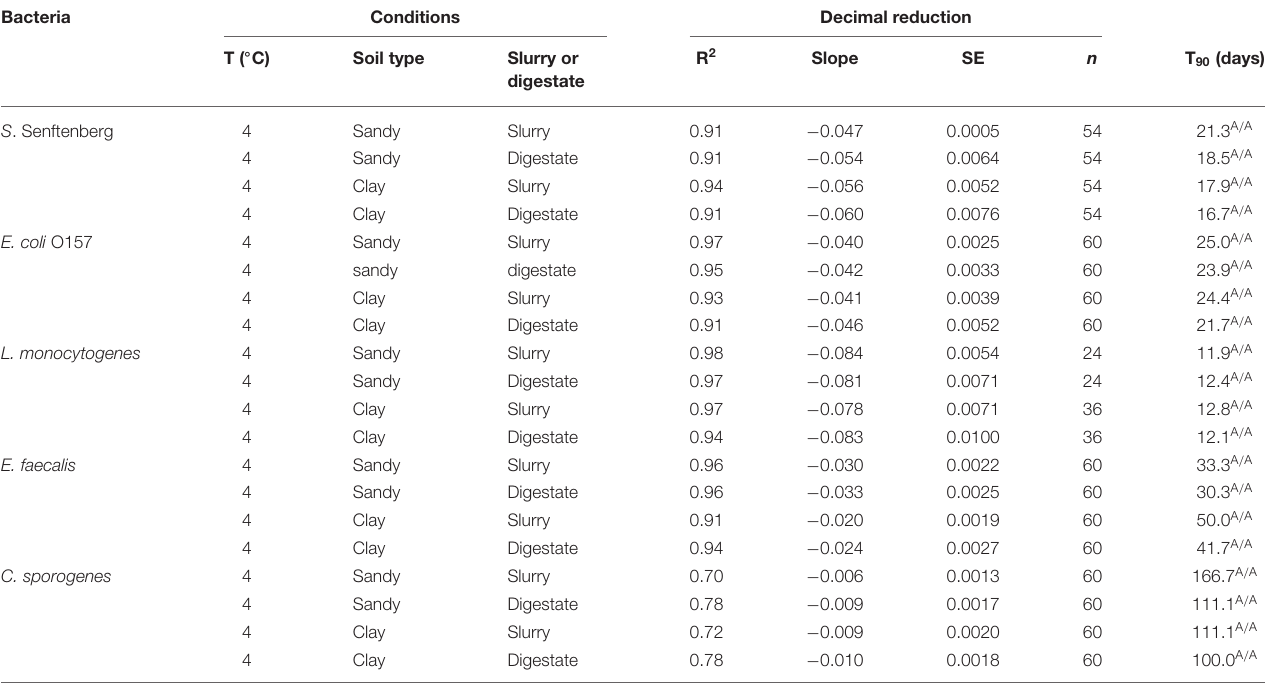
TABLE 2 | T 90 values for the different bacteria applied in slurry and digestate to sandy loam and clay loam soils and stored at 4 ◦ C in the laboratory trials. Bacteria